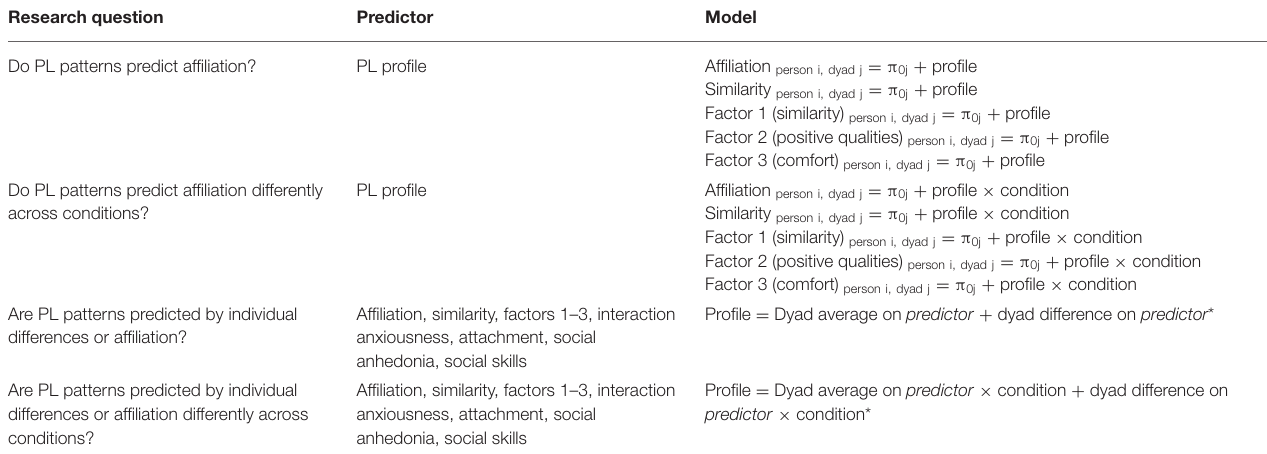
TABLE 2 | Models for each research